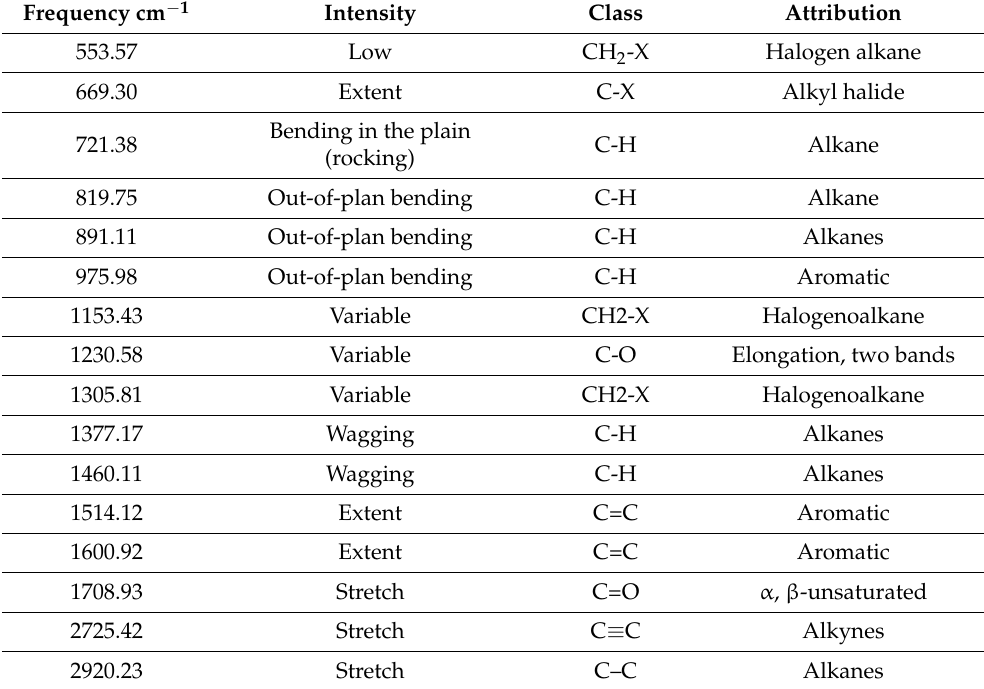
Table 2. Analyses of IR spectra (new oil).